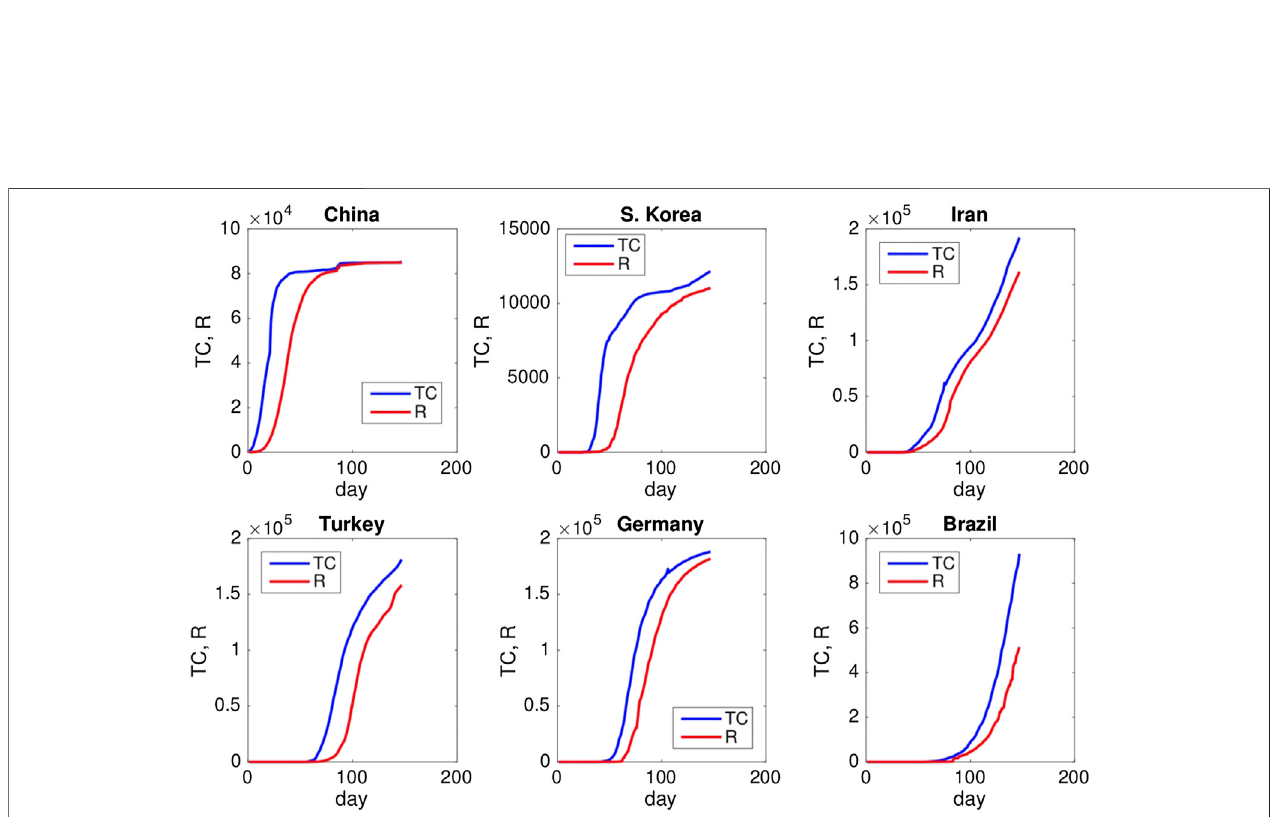
FIGURE 3 | Graphs of total cases (TC) and removed individuals (R) for selected countries. The dataset of each country is collected according to published of fi cial reports and available at the website http://www.worldometers.info/coronavirus/ (last access: June 28, 2020). Updated data are also available at the website http:// epikhas.khas.edu.tr/. The last data in this work were collected on the 16th of June 2020. Data cover the period January 22 – June 28, 2020, and in the following, “ Day 1 ” corresponds to January 22, 2020.